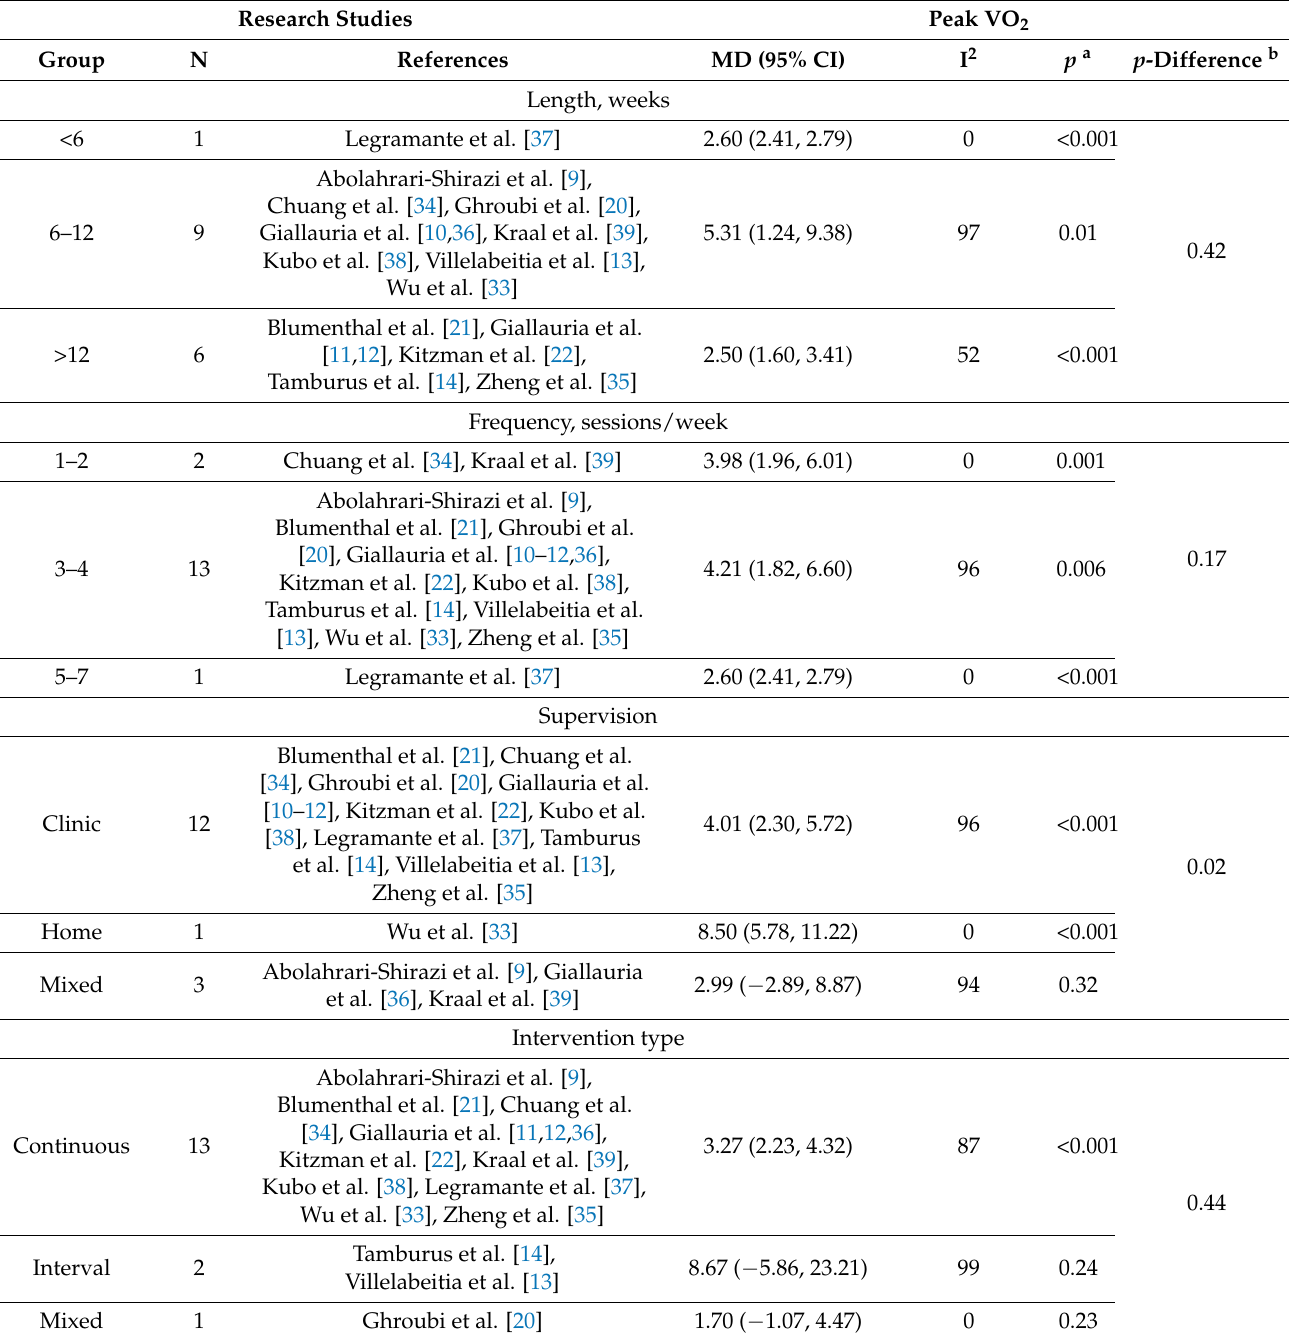
Table 3. Subgroup analyses assessing potential moderating factors for VO 2 peak increase in studies included in the meta-analysis by population